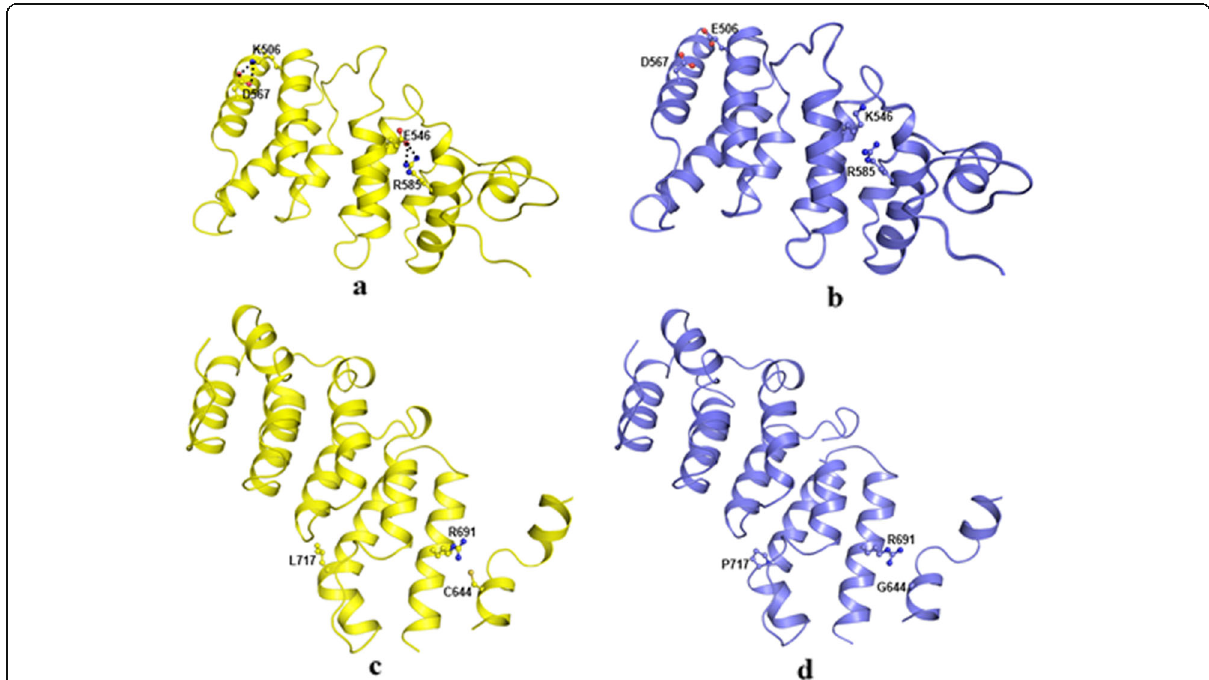
Fig. 4 Cartoon representation of tuberin domain of wild type TSC2 (cartoon, yellow) in ( a & c ) and ( b ) mutants (cartoon, blue) in ( b ) Lys506Glu and ( d ) Glu546Lys. Important residues have been represented in ball and stick and hydrogen bonded interactions are shown as black dotted